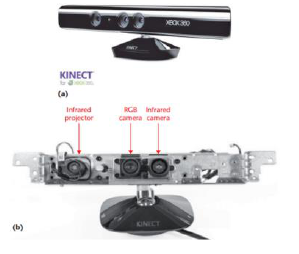
Figure 2. Kinect 2.0 sensor